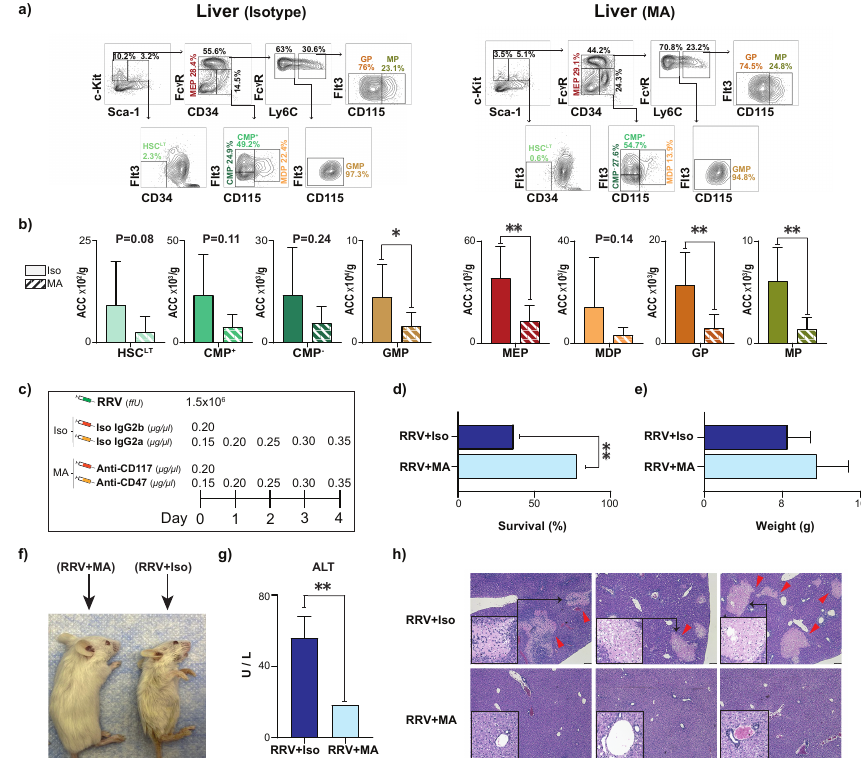
Figure 6. Antibody-mediated myeloablation depletes myeloid progenitor populations and protects mice from perinatal liver injury. ( a ) Representative flow plots demonstrating gating strategy of hematopoietic stem cells (HSC LT ), common myeloid progenitors (CMP), and terminal myeloid progenitors (TMP) in liver of isotype (Iso)- and myeloablative (MA)-injected 3-day-old (P3) mice. ( b ) Quantification of absolute cell counts (ACC) of HSC LT s, CMPs, TMPs in P3 livers from Iso- ( n = 6) and MA ( n = 8) mice. ( c ) Dosage schedule illustrating rhesus rotavirus (RRV) injection, Iso, and MA. ( d ) Percent survival of RRV+MA ( n = 27) vs. RRV+Iso ( n = 22) injected controls at three weeks of life. ( e ) Pup weights of RRV+MA ( n = 15) vs. RRV+Iso ( n = 5) injected controls at three weeks of life. ( f ) Pictures illustrating phenotypic changes in mice after RRV+MA and RRV+Iso at three weeks of life. ( g ) Quantification of alanine transferase (ALT) in serum of RRV+MA ( n = 3) treated mice vs. RRV+Iso ( n = 3) injected controls at three weeks of life. ( h ) Histological H&E sections (5 × ) of livers from animals in both groups three weeks post-injection with either RRV + Iso or RRV + MA. Red arrows indicate necrotic foci. Black boxes indicate 20 × magnified insets (necrotic foci are shown in RRV + Iso mice). p -value * < 0.05, ** < 0.01. Error bars represent mean ±